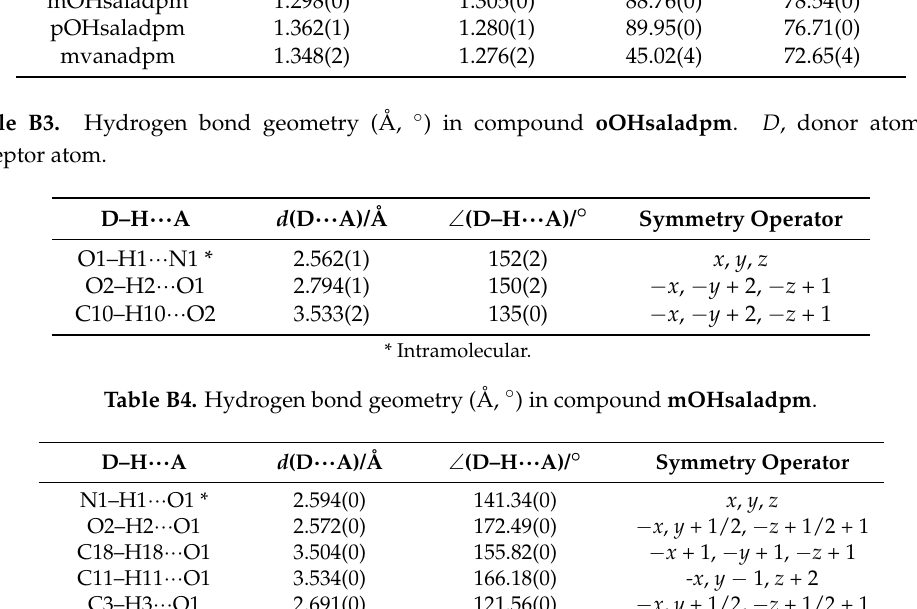
Table B2. Values of C2–O1 and C7–N1 bond distances and of dihedral angles (dihedral angle: the angle between best planes calculated trough: φ 1 , C1–C6 and C9–C14 rings; φ 2 , C1–C6 and C15–C20 rings).